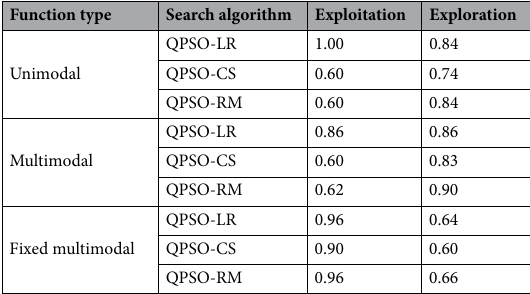
Table 10. Exploitation and exploration